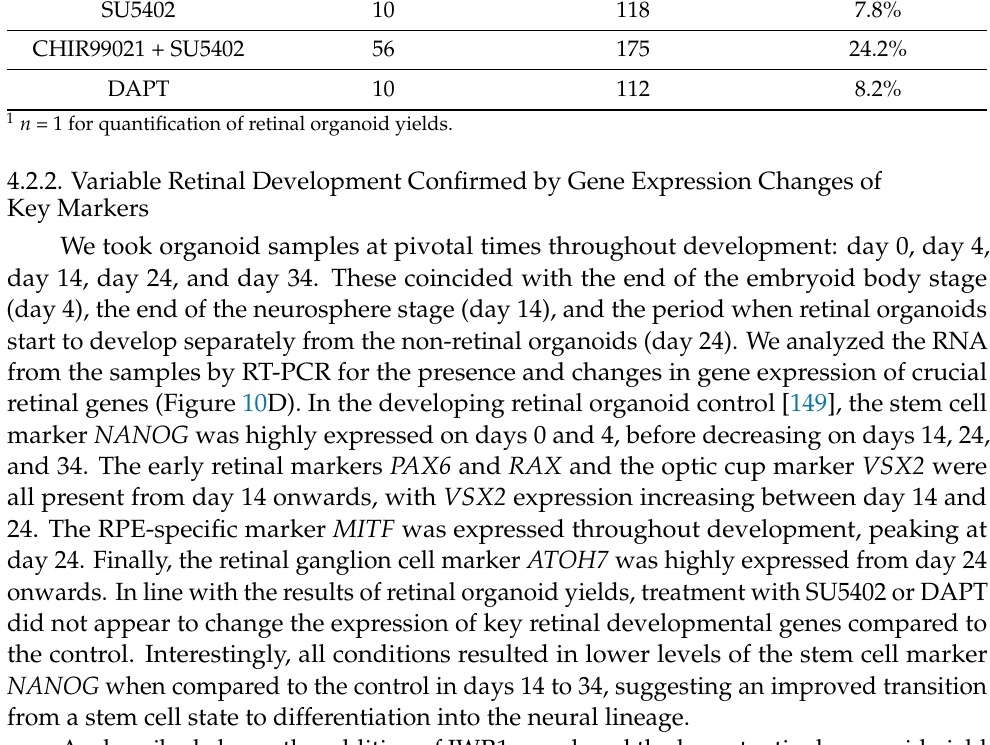
Table 2. Retinal organoid yields. Cultures were analyzed on day 25, and both retinal and non- retinal organoids were manually counted for each condition through brightfield microscopy im- ages. The yield of retinal organoids compared to the total amount of organoids was then calcu- lated for each condition either focusing on the early-stage regulation (Rock Inhibitor, IWR1e, IGF1, SB431542/LDN193189) or late-stage regulation (CHIR99021, SU5402, CHIR99021/SU5402, DAPT) of signaling pathways. Number of Retinal Number of Yield of Retinal Condition Organoids Non-Retinal Organoids Organoids 1 Control 9 80 10.1% Rock Inhibitor 3 114 2.6% IGF1 17